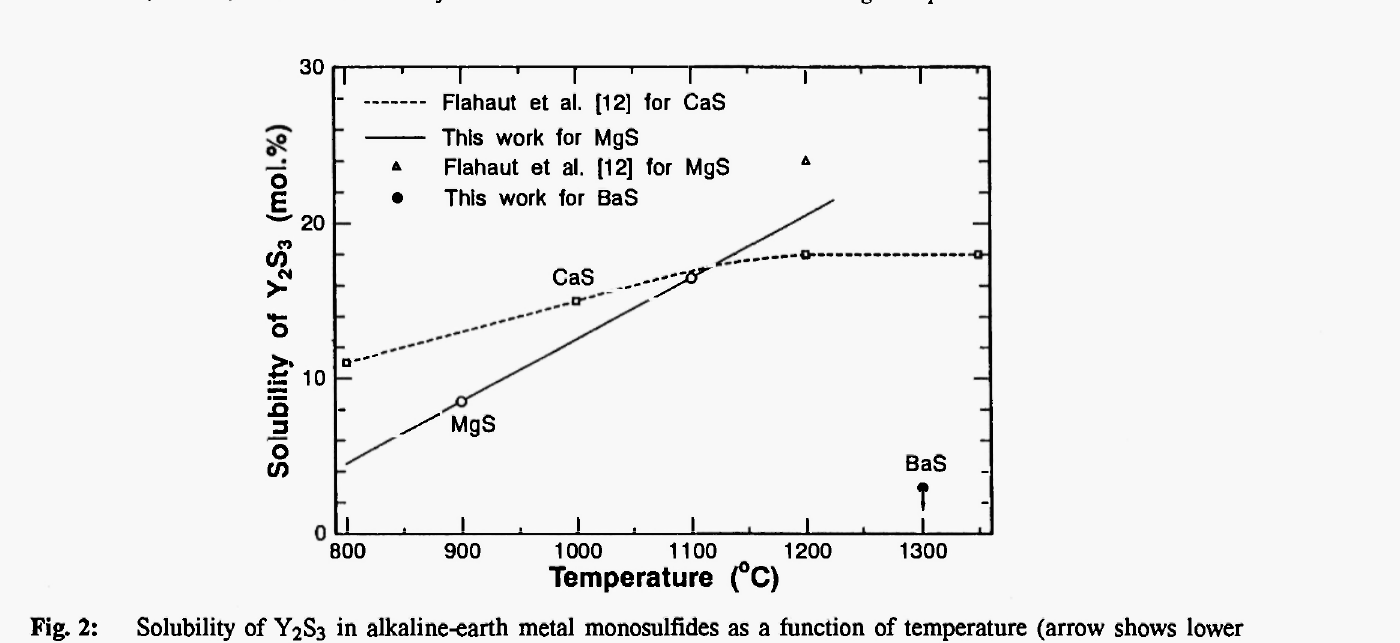
Fig. 2: Solubility of Y2S3 in alkaline-earth metal monosulfides as a function of temperature (arrow shows lower solubility).